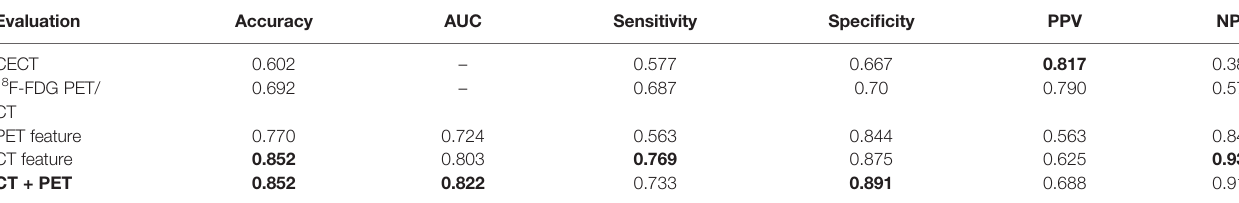
TABLE 2 | Results for predicting lymph node metastases in independent validation cohorts. Evaluation